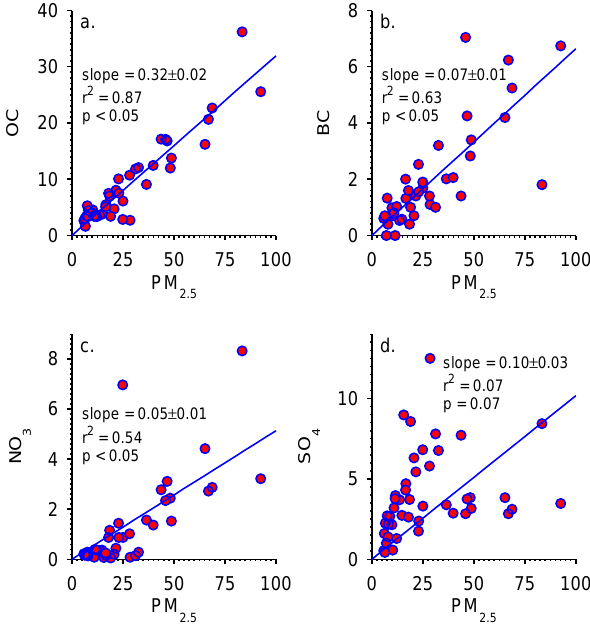
Fig. 3. Correlation of mass concentrations ( µ g/m 3 ) of (a) organic carbon (OC), (b) black carbon (BC), (c) nitrate ions (NO 3 ) , and (d) sulfate ions (SO 4 ) with particulate matter with diameters less than 2.5 µ m (PM 2 . 5 ) . Listed in the figures are the slopes and 95% con- Figure 3. Correlation of mass concentrations (µg/m 3 ) of (a.) organic carbon (OC), (b.) black fidence interval of the linear regression, the correlation coefficients ( r 2 ) , and the p-values ( p ) of the correlation. ), and (d.) sulfate ions (SO ) with particulate matter with carbon (BC), (c.) nitrate ions (NO 3 4 ). Listed in the figures are the slopes and 95% confidence diameters less than 2.5 µm (PM 2.5 absorption, OC and BC are used since there is no evidence interval of the linear regression, the correlation coefficients (r 2 ), and the p-values (p) of the suggesting that OM is more absorbing than correlation.